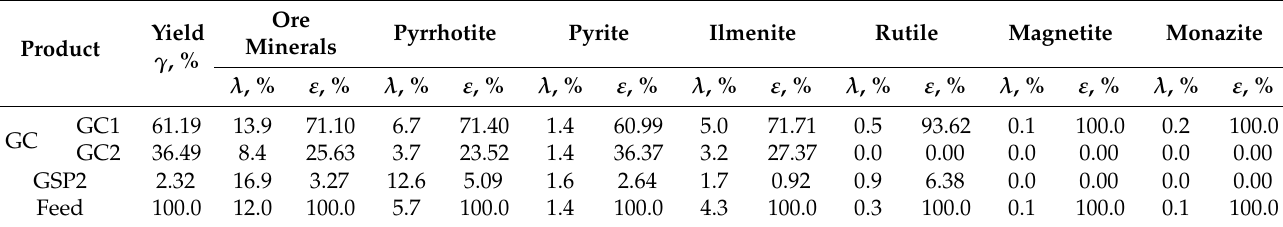
Table 7. The balance of gravity separation (cleaning stage).